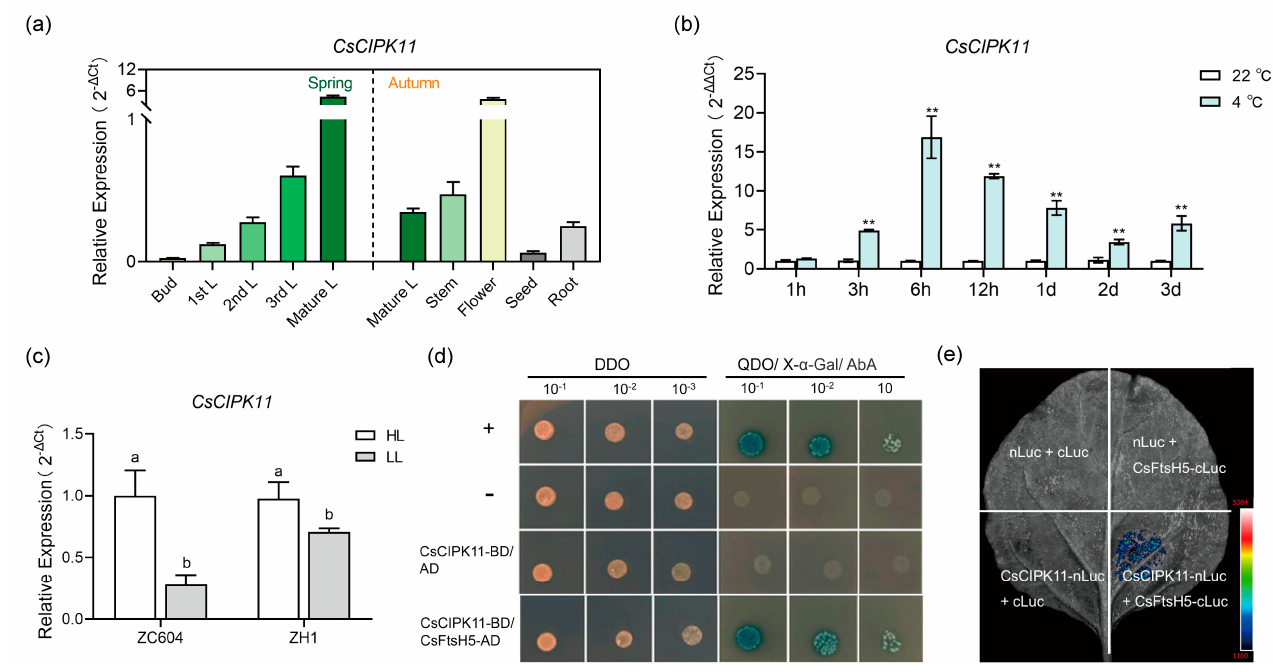
Figure 4. CsFtsH5’s interaction with CsCIPK11. ( a ) The expression patterns of CsCIPK11 in tea plant tissues, including bud, 1st L, 2nd L, 3rd L, mature L, stem, flower, seed, and root. Samples were collected on April 2020 and October 2020. ( b ) The CsCIPK11 expression in tea plants under 22 ◦ C and 4 ◦ C treatments for 1, 3, 6, and 12 h, as well as 1, 2, and 3 d. Data are shown as the mean ± SEM ( n = 3). Asterisks indicate significant differences according to t -tests (** p < 0.01). ( c ) The expression patterns of CsCIPK11 in leaves of ZC604 cultivar and ZH1 cultivar under 100% and 10% sunlight conditions. Means of three replicates and standard errors are presented; different letters above the column indicate significant difference at p < 0.05 using LSD’s test. Values in ( a , c ) are expressed relative to the expression levels of reference gene using formula 2 − ∆ Ct . Values in ( b ) are expressed relative to the expression levels of 22 ◦ C group using formula 2 − ∆∆ Ct . CsPTB was used as a reference gene in expression analysis. ( d ) Y2H assay of pGBKT7-CsCIPK11 and pGADT7-CsFtsH5 in AH109 strain. DDO, SD/ − Leu/ − Trp; QDO, SD/ − Leu/ − Trp/ − His/ − Ade; X, X- α -gal. pGBKT7-53 and pGADT7-T acted as the positive control, while pGBKT7-lam and pGADT7-T served as the negative control. ( e ) Luciferase complementation imaging analysis of CsCIPK11-nLuc and CsFtsH5-cLuc in Nicotiana benthamiana leaves. CsCIPK11-nLuc with cLuc, nLuc with CsFtsH5-cLuc, and nLuc with cLuc served as